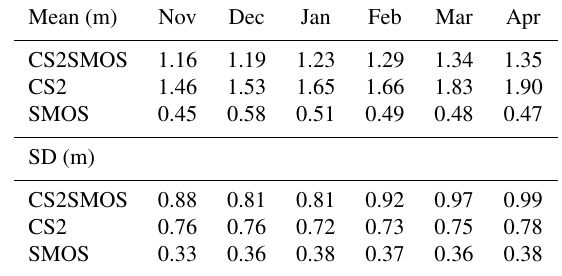
Table 2. Arctic-wide mean and standard deviation (SD) of the merged product (CS2SMOS), the individual CryoSat-2 (CS2)